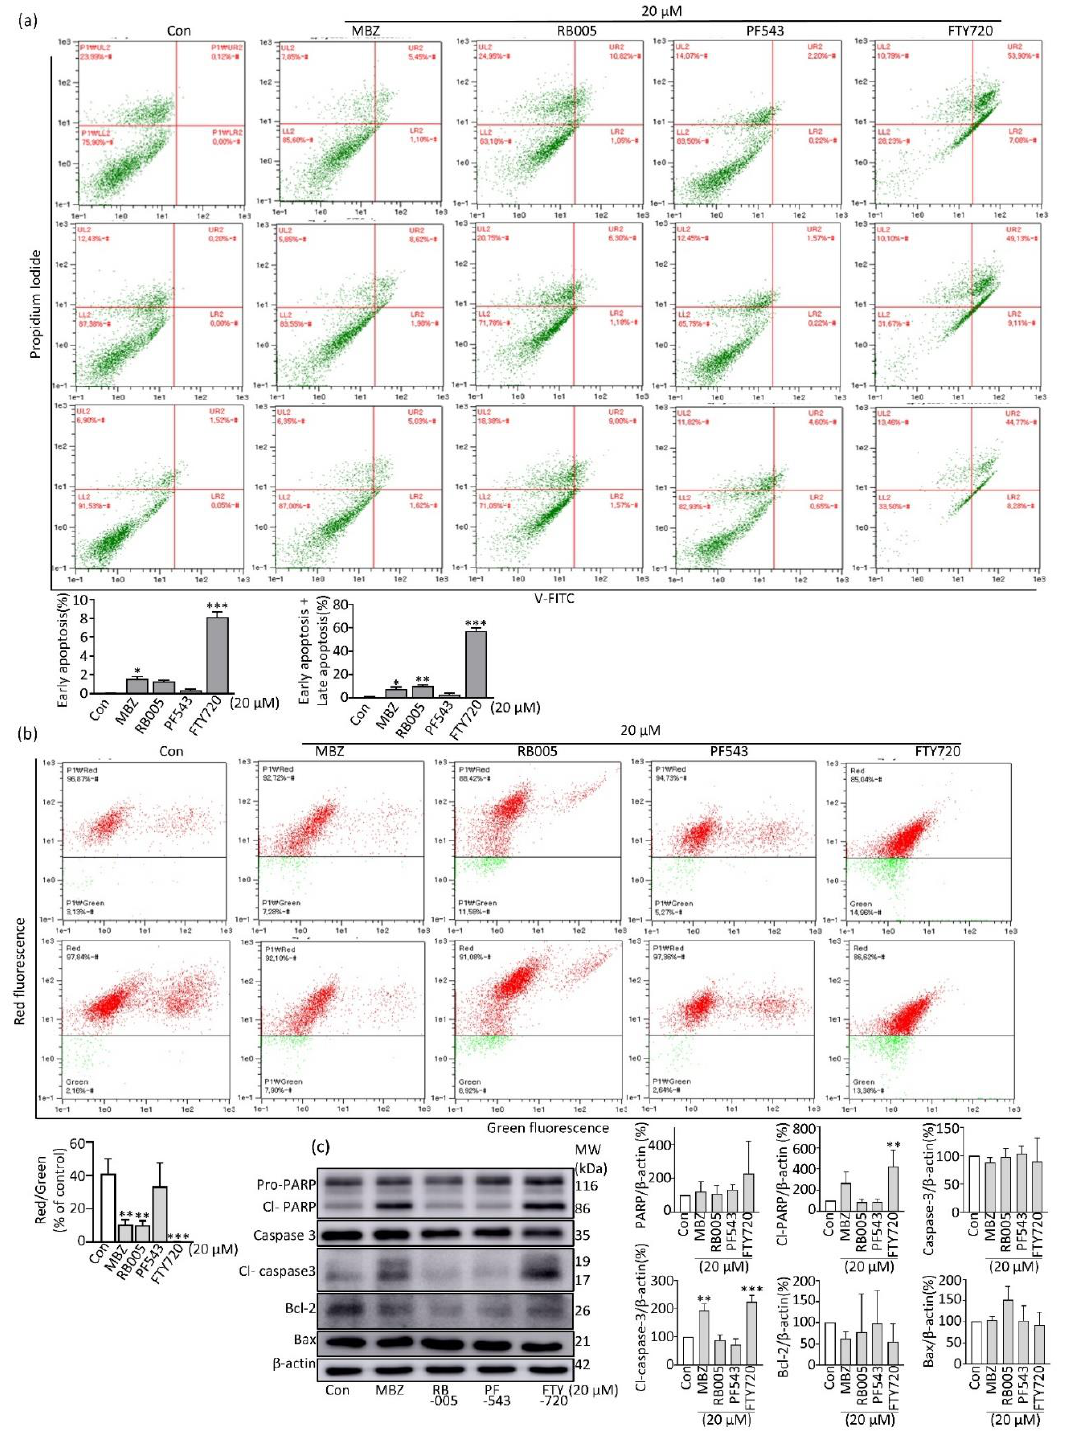
Figure 3. Mebendazole promote apoptosis in pancreatic cancer cell through intrinsic